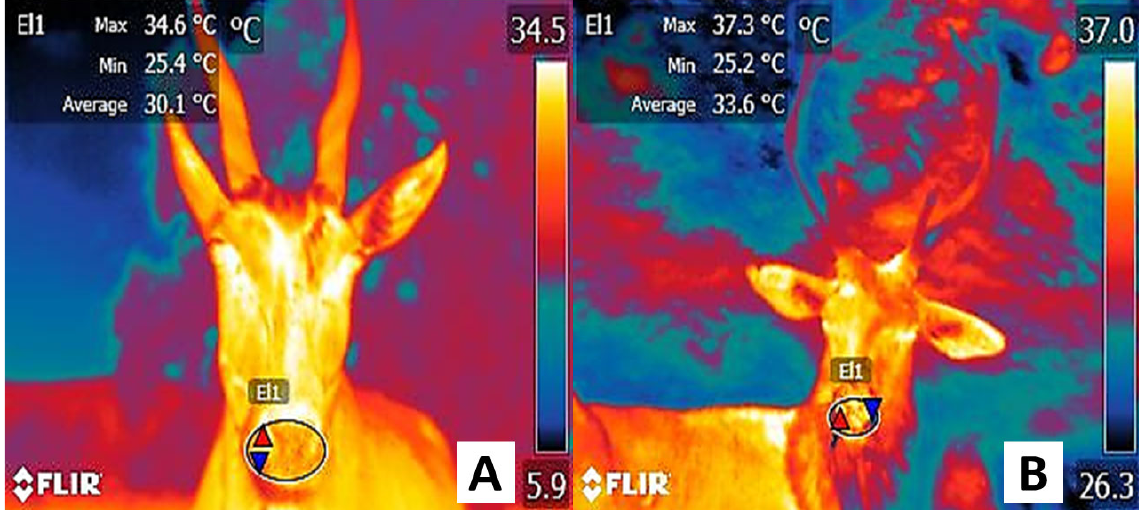
Figure 8. Comparison of the thermal state of the nasal region in healthy and sick animals. ( A ). Tem- perature of the nasal region in a gazelle ( Gazelle gazella ). This animal presents no health alterations or clinical signs, and its overall health condition is good, as shown by the maximum temperature (red triangle) of 34.6 ◦ C in the nasal region (El1) and an average value of 30.1 ◦ C. ( B ). Temperature of the nasal region in a deer ( Odocoileus virginianus ). In this case, an adynamic animal with upper respiratory disease and nasal discharge presents a maximum nasal temperature (El1) (red triangle) of 37.3 ◦ C and an average temperature of 33.6 ◦ C. Compared to the healthy animal, a difference between 2.7 ◦ and 3.5 ◦ C can be seen. This may be due to a pathological process that includes the release of cytokines and prostaglandin E 2 , which can cause a feverish state and promote the activation of thermoregulation mechanisms such as vasodilation to effectuate heat